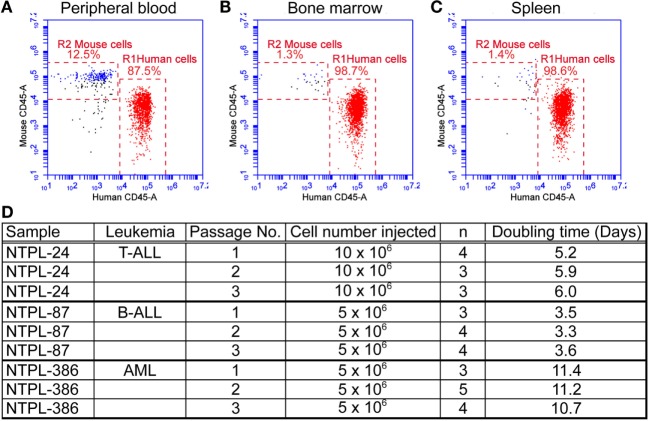
Primary leukemia samples can be serial passaged in NSG-B2m mice. NSG-B2m mice were injected with NTPL-24 cells. When the percentage of CD45+ cells in mouse peripheral blood reached above 85%, mice were euthanized. Representative flow cytometry plots showing the percentage of human leukemic cells in mouse peripheral blood (A), bone marrow (B), and spleen (C) in these mice. (D) Table showing the growth characteristics of leukemia samples over multiple passages.